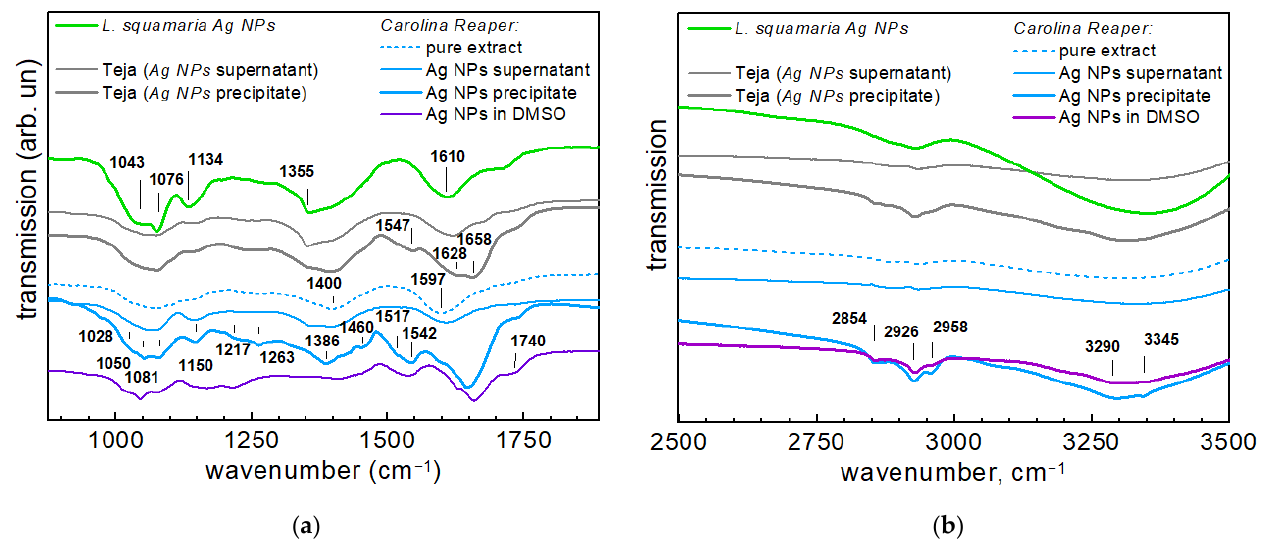
Figure 4. IR transmission spectra of phytosynthesized Ag NPs in the range of 500 – 1800 cm −1 ( a ) and of 2500 – 3500 cm −1 ( b ). The spectra shifted vertically for convenience. To avoid overloading the figure, the wavenumbers of absorption peaks are marked only in those spectra where they occur at the largest intensity or are most distinct.